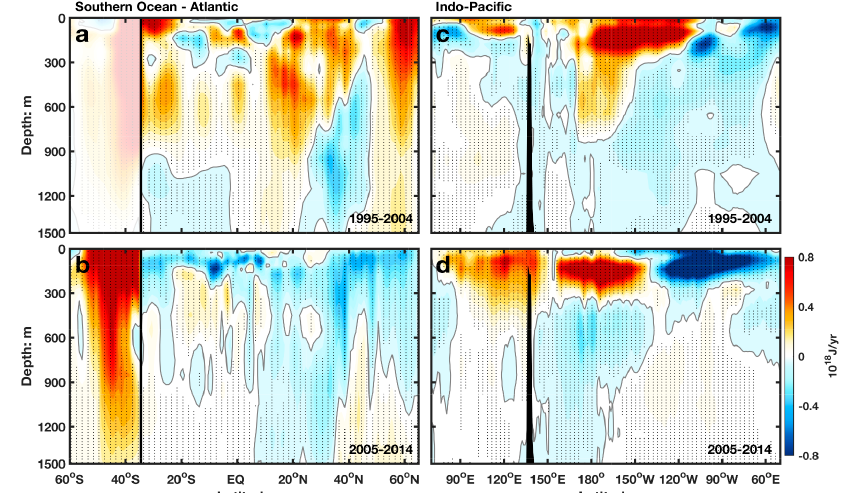
Figure 6. Linear trend of OHC cross-sections: ( a , b ) linear trends in the two periods indicated, zonally integrated (not averaged) over the longitude of the Atlantic basin as a function of latitude. South of 35S, the zonal integration is circumpolar (skipping over the land). The thin black line at 35S separates the two latitude regions with very different zonal extents. ( c , d ) OHC linear trends in the two periods indicated, as a function of longitude in the Indo-Pacific sector, meridionally integrated (not averaged) from 35S to the northern boundary of the ocean basins. The topography in the Indonesia Through Flow is 8S–8N averaged and shown in black. Top two panels are linear trends over 1995–2004. Bottom two panels are the linear trends over 2005–2014. Each period is 10 years. The Southern Ocean part is blanked out in ( a ) due to poor data quality. Regions where signal is statistically significant above 95% confidence level are